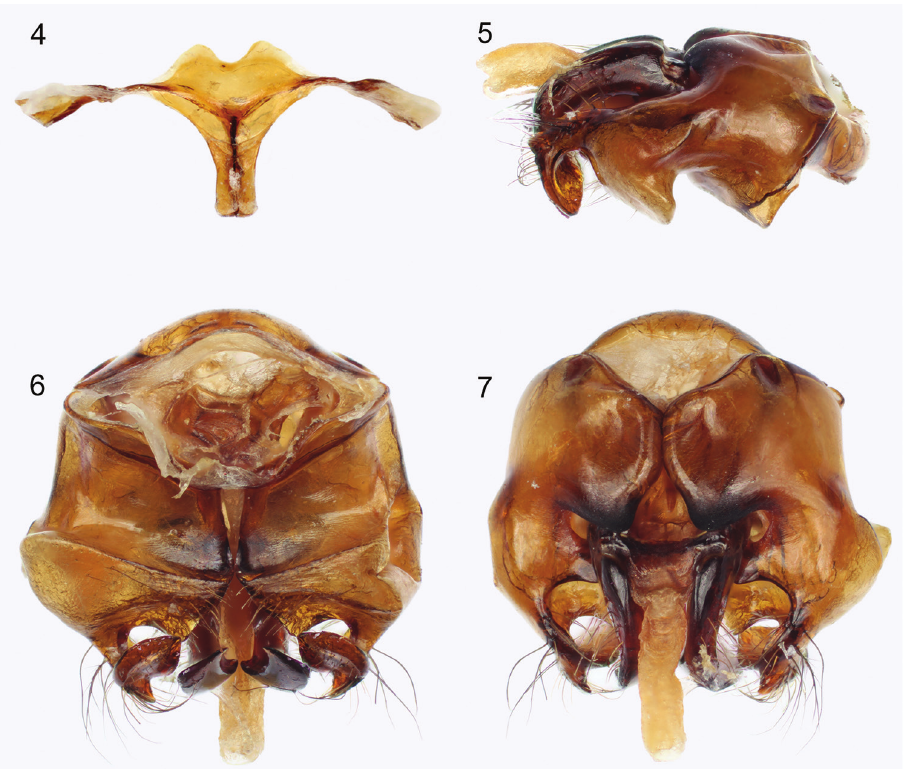
Figures 4–7. Male terminalia of Xylocopa ( Koptortosoma ) sarawatica Engel, sp. n. 4 Metasomal